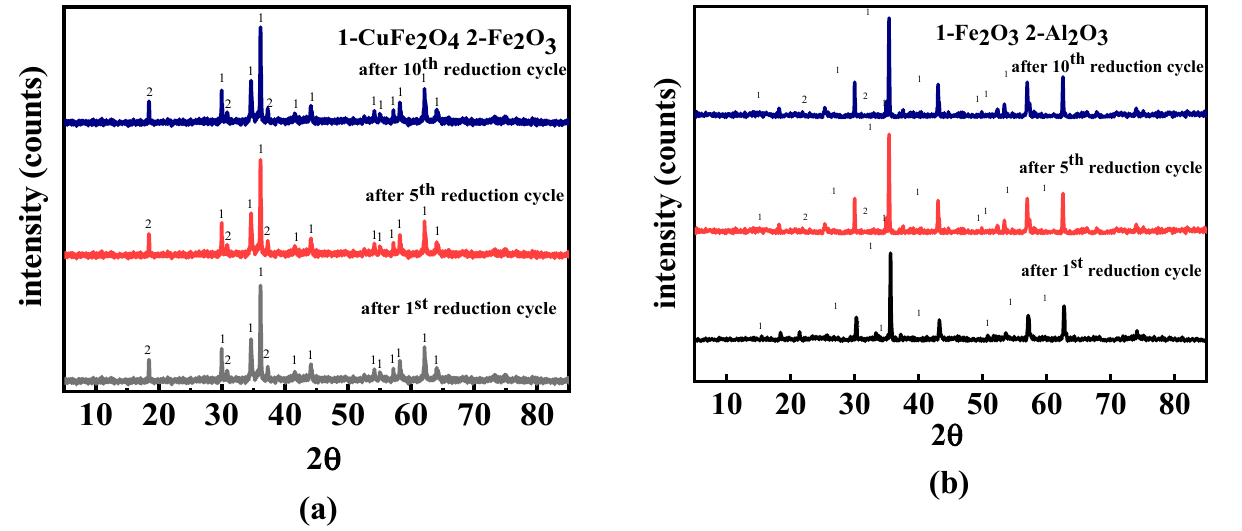
Figure 12. Trends of NO and NO 2 over time during reduction using iron-based oxygen carriers and